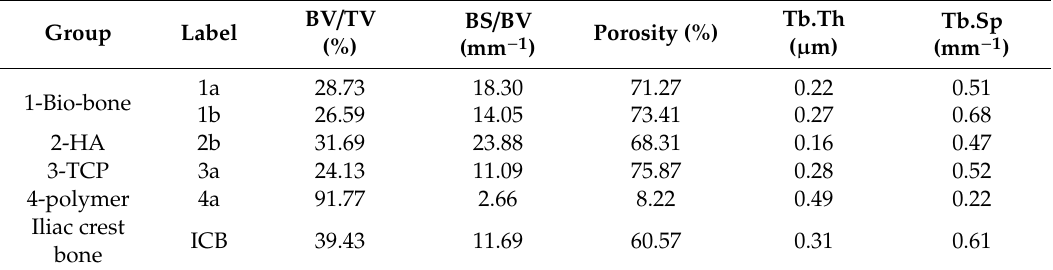
Table 2. Morphological parameters of the biomaterials selected before the implantation.